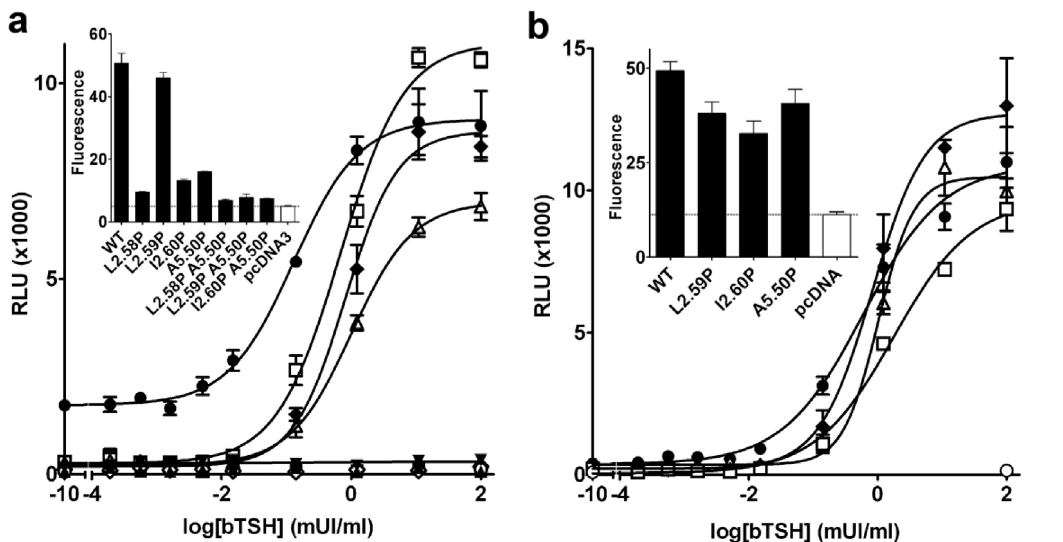
Fig 5. TSH induced cAMP response of TSHR mutants. Typical dose-response curves of cAMP accumulation induced by TSH on HEK-293 cells transfected with pcDNA3.1 plasmids encoding WT or mutated TSHRs. In (a), the cells were transfected with the same amount of TSHR coding plasmids, leading to the cell membrane expression shown in insert. In (b), the cells were transfected with different amounts of TSHR coding plasmids to obtain similar levels of cell surface expression, shown in insert. The total amount of pcDNA3.1 plasmids was kept constant by addition of empty plasmids. Receptor symbols: closed circles, WT; closed down triangles, L2.58P; open squares, L2.59P; open triangles, I2.60P; closed diamonds, A5.50P; closed squares, L2.58PA5.50P; closed triangles, P2.59PA5.50P; open diamonds, I2.60PA5.50P.